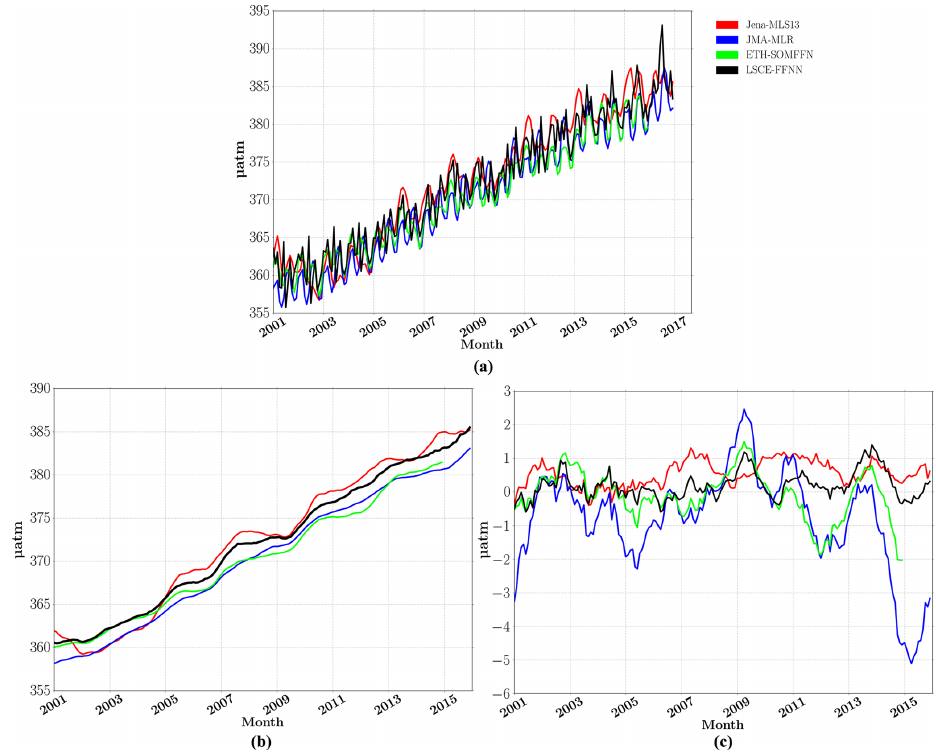
Figure 4. Global oceanic p CO 2 : Jena (red), JMA (blue), ETH-SOMFFN (green) and LSCE-FFNN (black). (a) Global average monthly time series, (b) the global 12-month running mean average and (c) yearly p CO 2 mismatch (difference between mapping methods and SOCAT